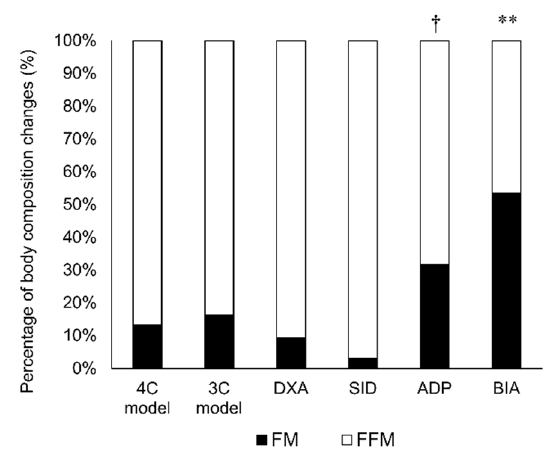
Figure 2. Ratio of body composition changes after rapid weight loss. Data are expressed as mean ± SD, n = 8. ** p < 0.01 vs. 4C model, 3C model, DXA, SID, and ADP using Bonferroni post-hoc test. † p < 0.05 vs. 4C model, 3C model, DXA, and SID using the Bonferroni post-hoc